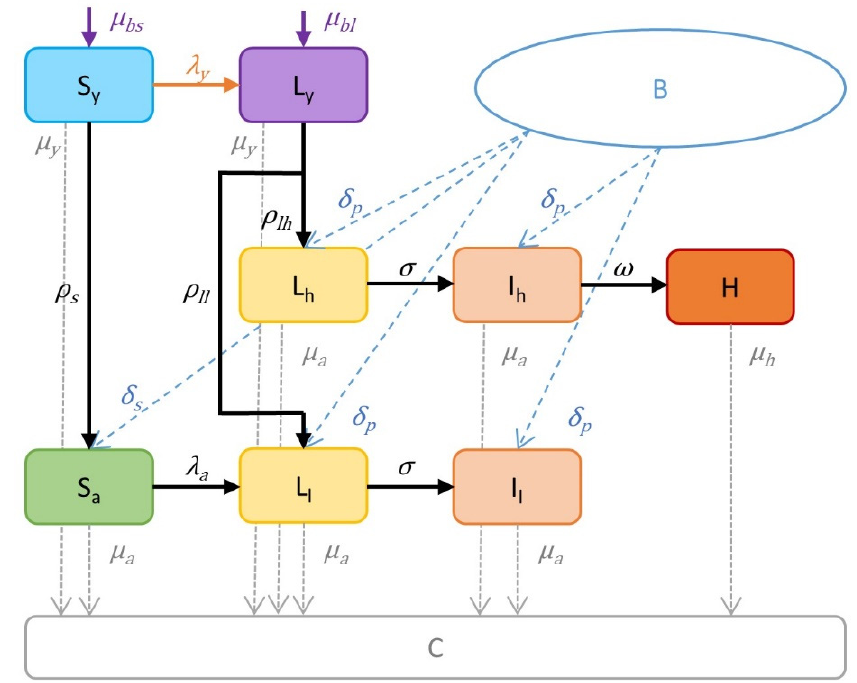
Figure 1. Flow diagram of the model for the spread of Mycobacterium avium subsp. paratuberculosis in a typical Slovenian dairy herd. Possible health states represented by boxes are susceptible young ( S y ); latent young ( L y ); latent cows ( L h ), infected cows ( I h ) and high shedding cows (H) on the high shedding pathway; susceptible cows ( S a ); latent cows ( L l ) and infected cows ( I l ) on the low shedding pathway; and culled, dead or sold animals (C). The bought compartment (B) represents animals outside the herd that can be introduced. The arrows represent how individual animals change from one state to another. All parameters and calculations are defined in Tables 1 and 2.